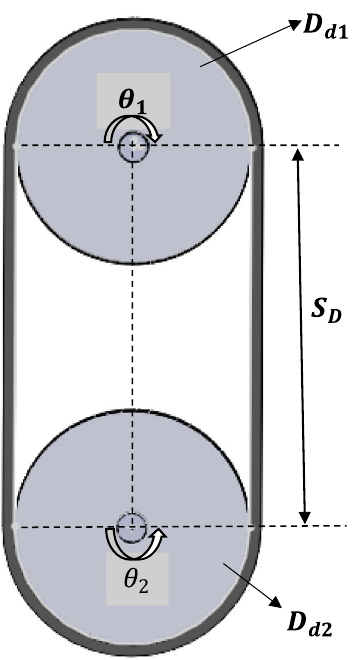
Figure 6. Sketch diagram of the belt pulley arrangement in belt elevator system.